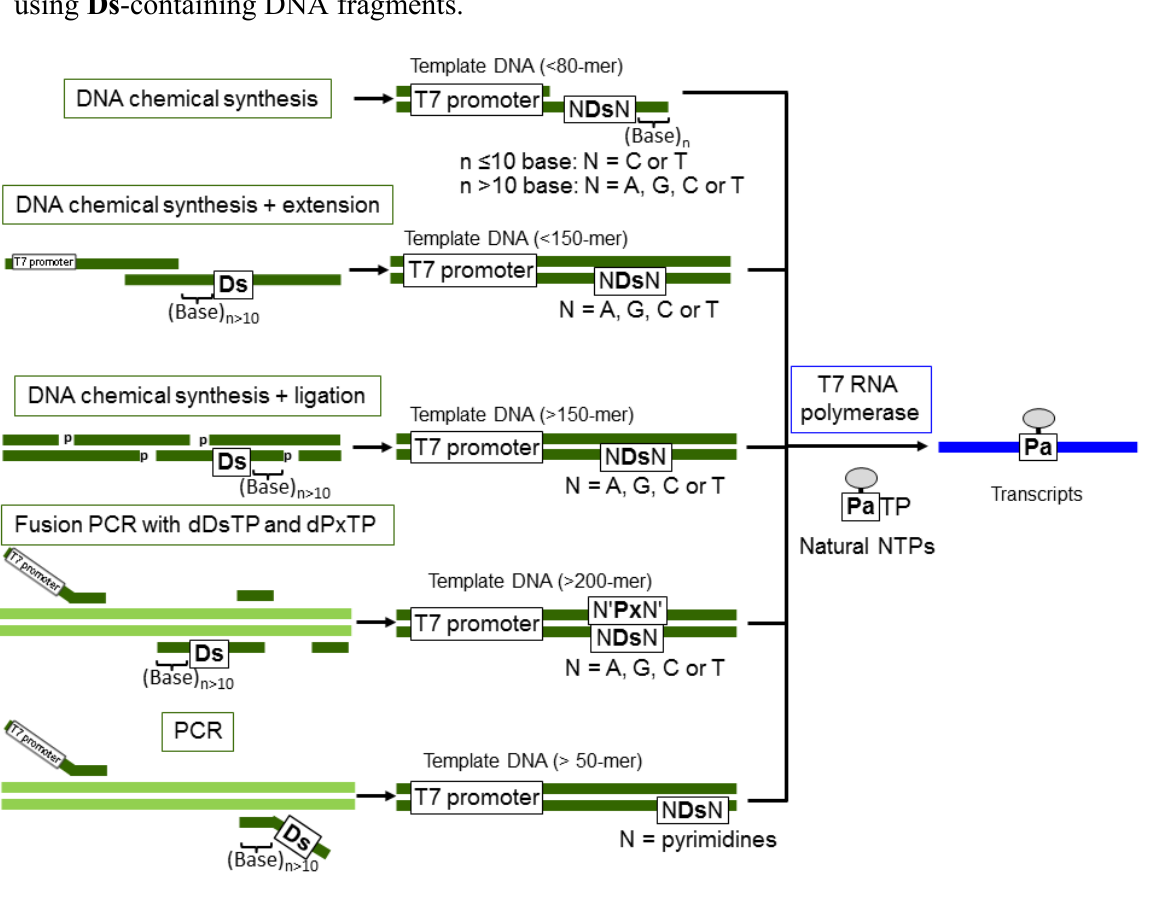
Figure 9. Schemes for the preparation of Ds -containing templates for T7 transcription, using Ds -containing DNA